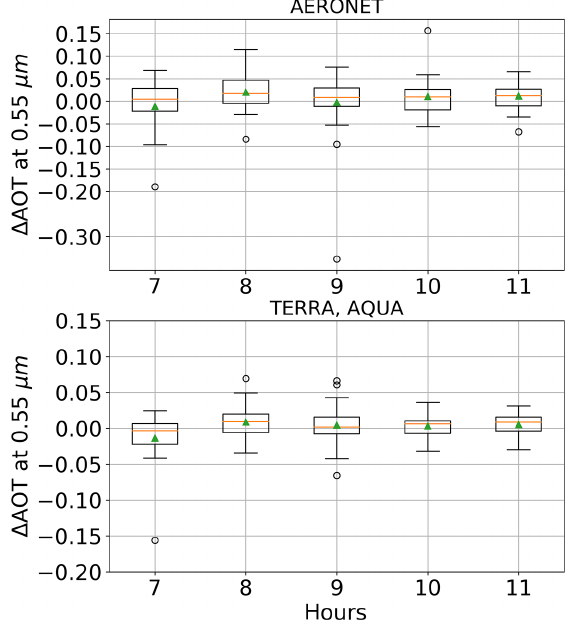
Figure 7. Daily variations of the (cid:49) AOT at 0.47µm ( (cid:49) AOT = AOT Moscow_MO_MSU − AOT Zvenigorod ), UTC time. The median is in the centre, the box is the first (Q1) and the third (Q3) quar- tiles, and the whiskers are Q3 + 1 . 5 · ( Q3 − Q1 ) and Q1 − 1 . 5 · ( Q3 − Q1 ) . Green triangles: means; points: outliers (2006–2017, with- out the data of 2009 because of technical problems at the Zvenig- orod AERONET site). The number of satellite and ground-based matchups is